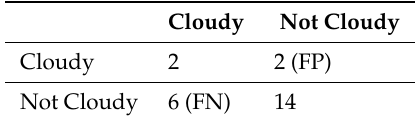
Table 6. Confusion matrix of the model with respect to the critical test